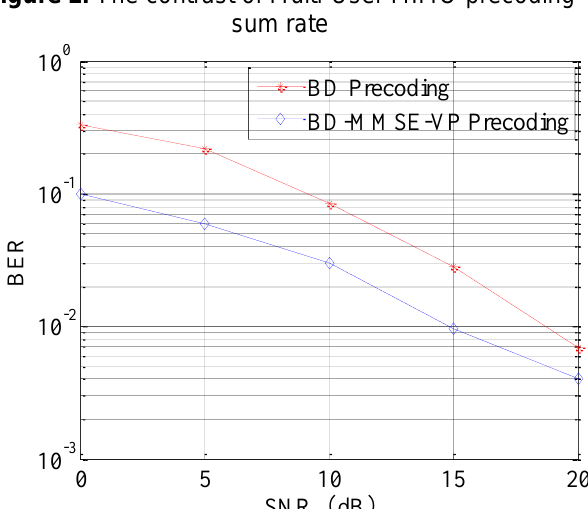
Figure 2. The contrast of Multi-User MIMO precoding